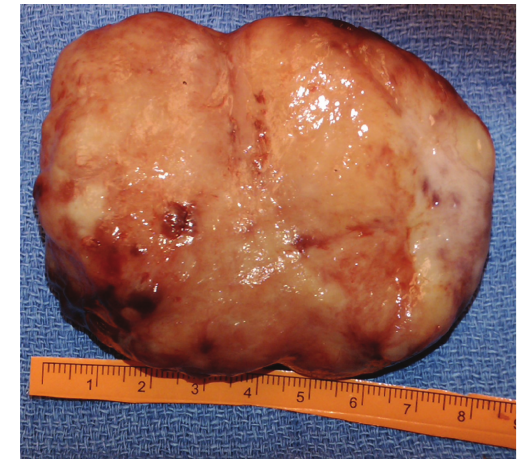
Figure 3: The enucleated esophageal schwannoma was yellowish- white, smooth, and well-defined without any pedunculated por-